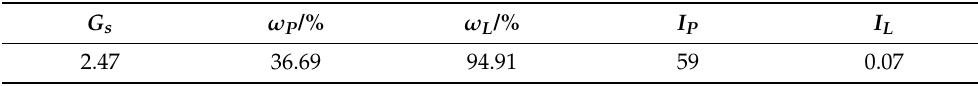
Figure 2. Particle size distribution curve of diatomite soil. Table 1. Physical indicators of diatomite